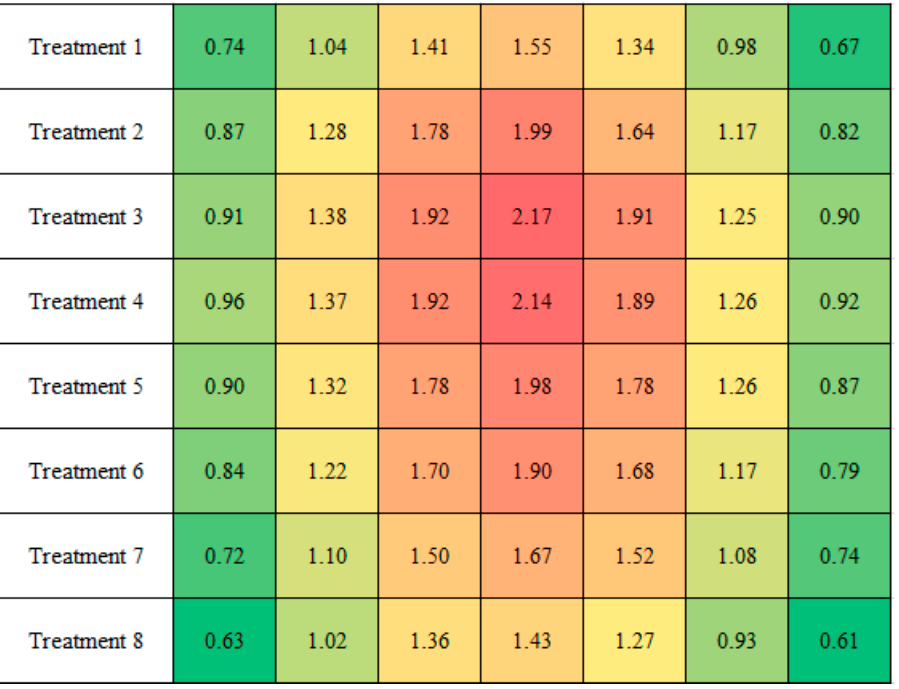
Figure A6. Map of UV light intensity (irradiance) measurements for UV ‐ C (222 nm) for Treatment 1 to Treatment 8. The color gradient green–yellow–red represents increasing UV light intensity. Units: mW/cm 2 .